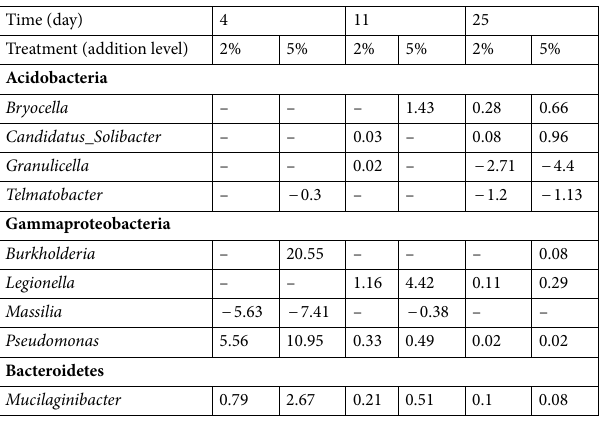
Table 1. Significant differences in relative abundance (%) of bacterial genera between the control and treatments with added root exudates (2% or 5%) at particular sampling